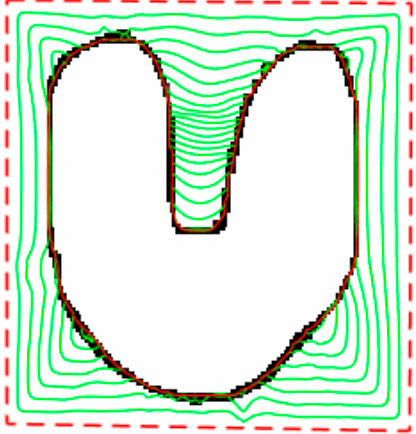
Figure 5. Segmentation results of U-shape image.